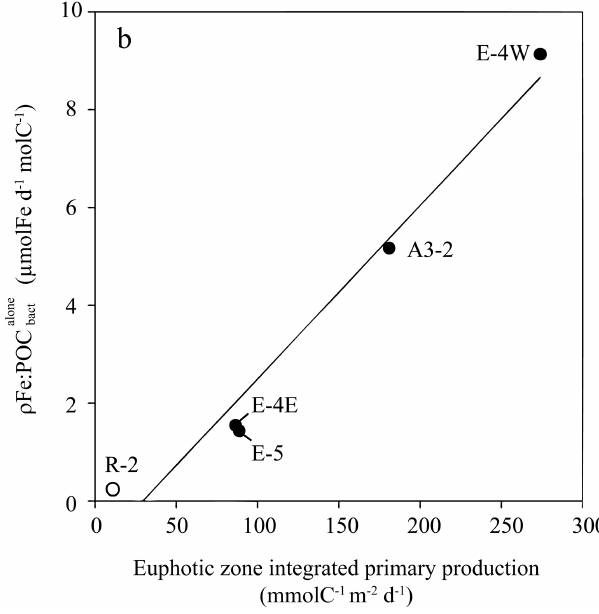
Figure 7. Relationship between the C-normalized bacterial Fe up- take (( ρ Fe:POC) alone ) and euphotic-zone-integrated primary pro- bact duction. The plotted line was obtained by least-squares regression ( r 2 = 0 . 97 with p = 0 . 002). Empty symbol represents the reference station R-2 and filled symbols are for Fe-fertilized